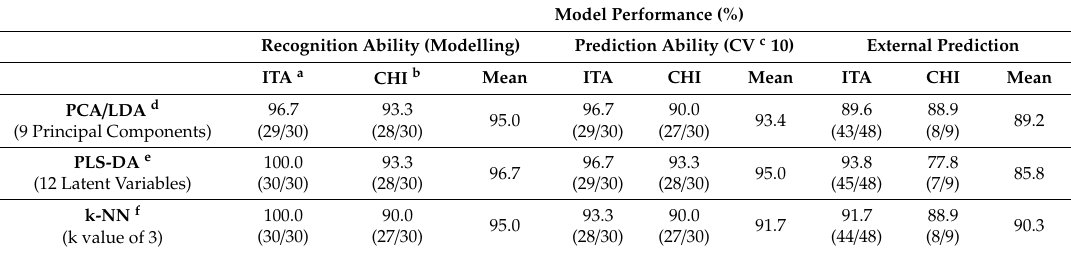
Table 2. Model performances in terms of recognition, cross validation (CV) prediction abilities and external prediction for all models built to classify acacia honeys based on their geographical